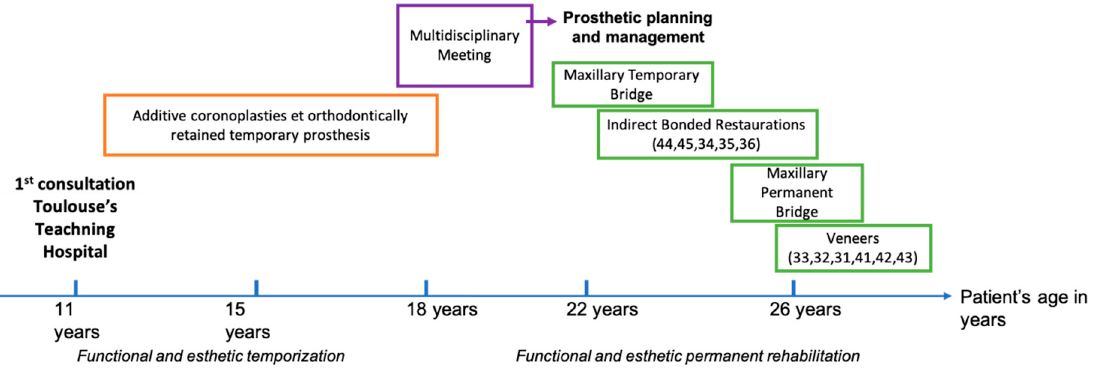
Figure 8. Timeline and summary of management and follow-up over 15 years.